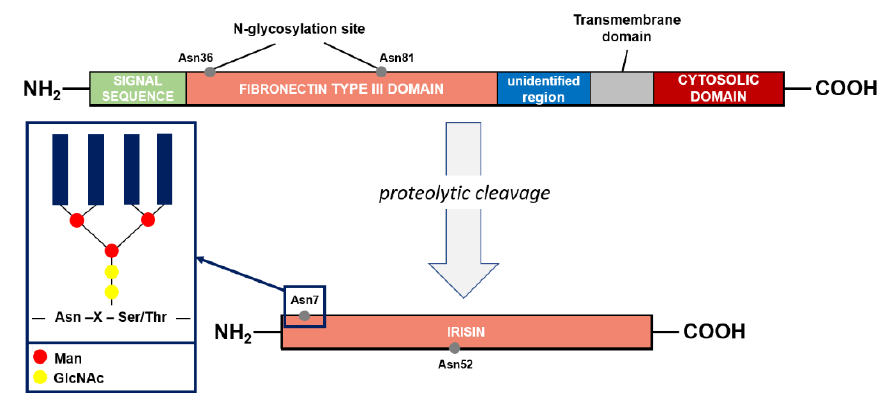
Figure 2. Fibronectin type III domain-containing protein 5 (FNDC5) structure and formation of irisin. The potential N-glycosylation sites are marked as gray dots. Asn, asparagine; GlcNAc, N-acetylglucosamine; Man, mannose; Ser, serine; Thr, threonine; X, any amino acid except proline.